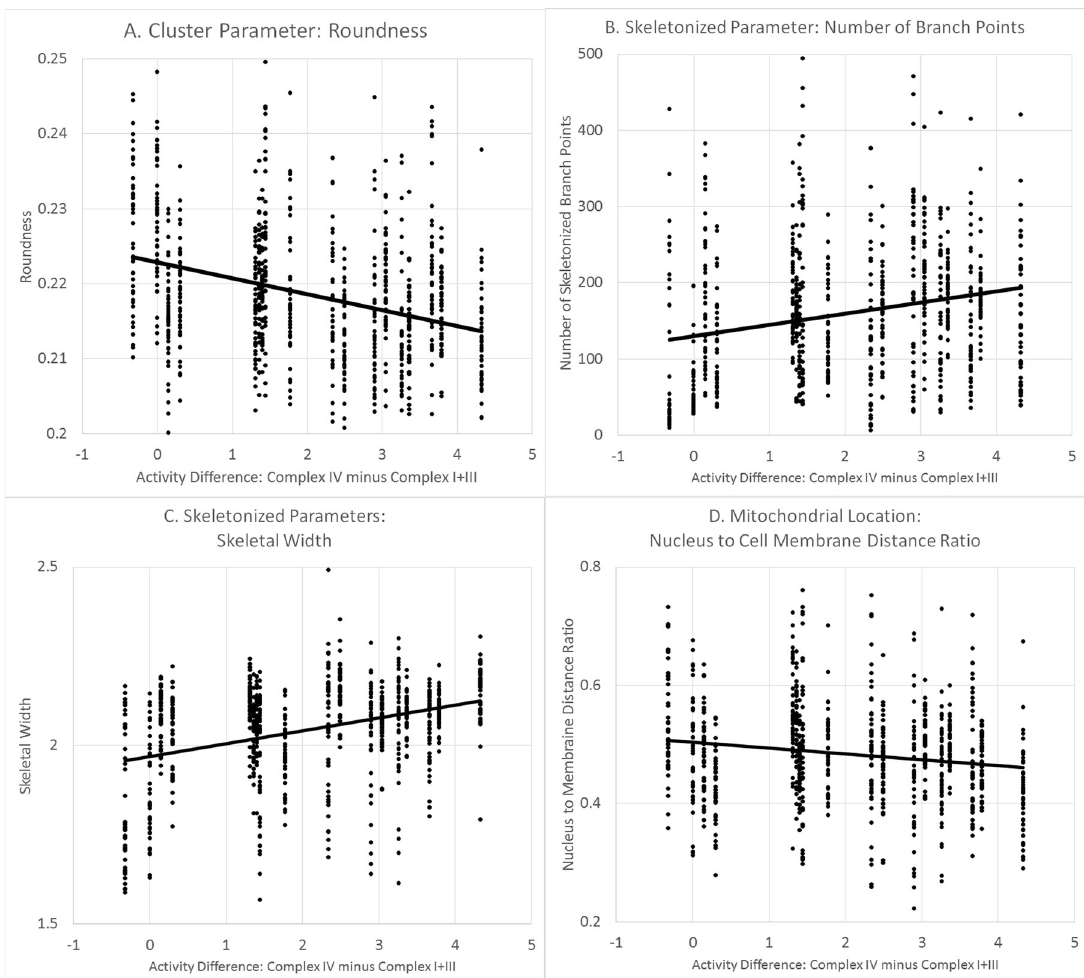
Fig. 3 Relationship between mitochondrial respiration and morphology in autism spectrum disorder fi broblast cell line. Examples of the relationship between mitochondrial morphological parameters and mitochondrial ETC complex activity for fi broblasts derived from children with ASD. Individual morphological measurements from each cell examined are